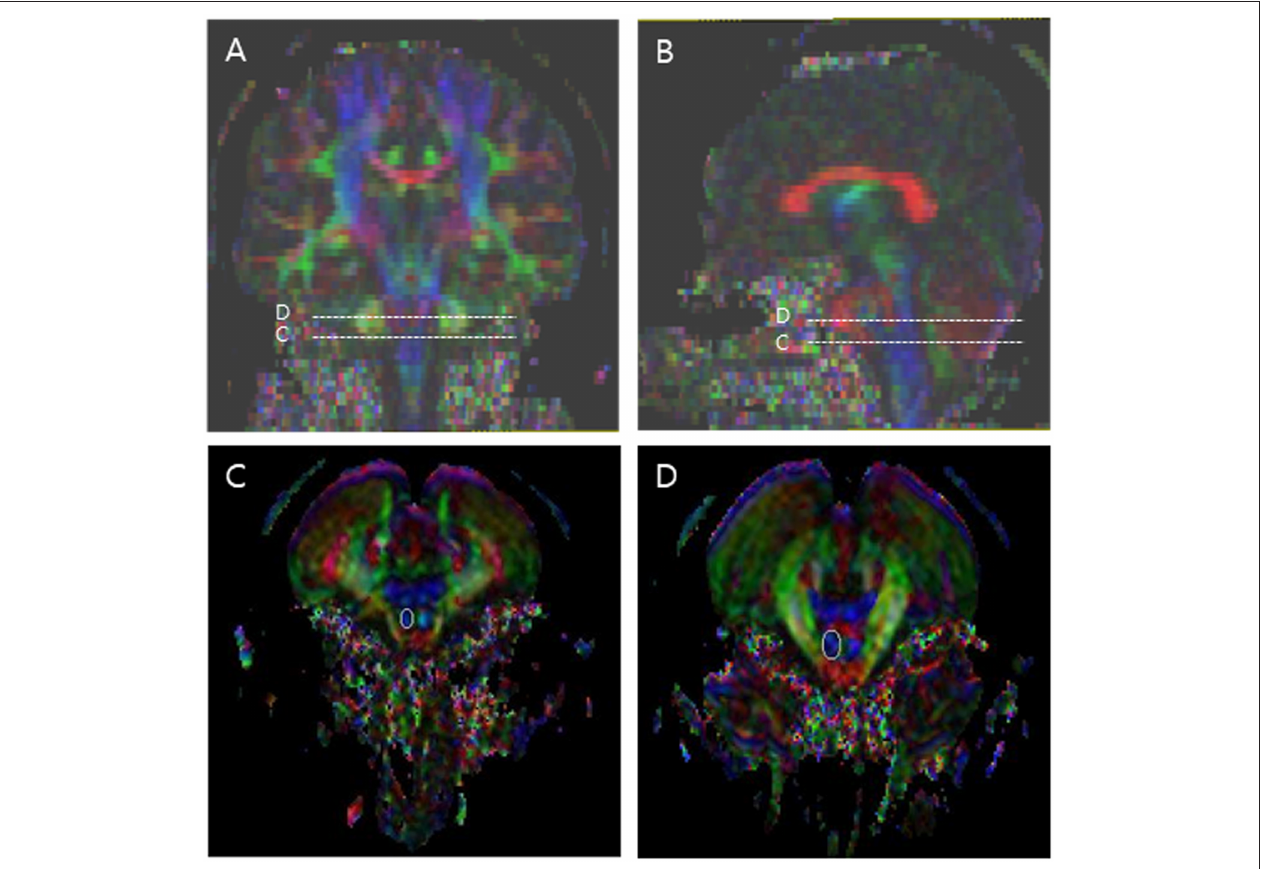
FIGURE 1 | Regions of interest (ROIs) used to reconstruct the corticospinal tract (CST) on diffusion tensor imaging. The stippled lines indicate the ROIs. The solid lines indicate the seed ROI for the corticospinal tract. (A) Coronal color FA map; (B) Sagittal color FA map; (C) The seed ROI of CST at the pontomedullary junction; (D) The seed ROI of CST at the